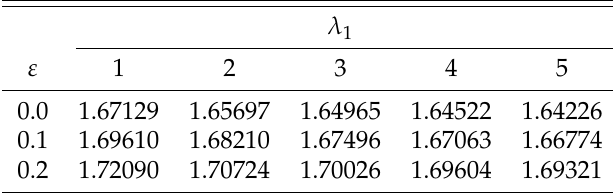
Table 3. Z (Heat transfer coefficient) as a function of λ 1 and ε . Here x = 0.1, Q = − 1.2, β 1 = 0.2, β 2 = 0.2, ϕ = π /4, M = 4, Br = 0.5.